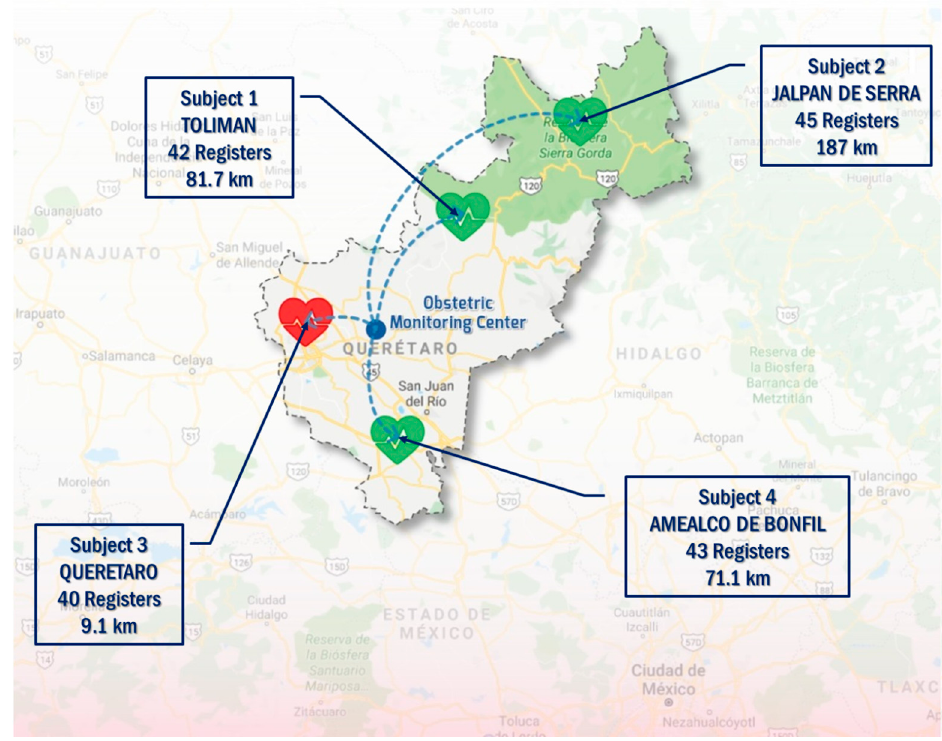
Figure 7. Map showing the location of the first four patients from Table 1.